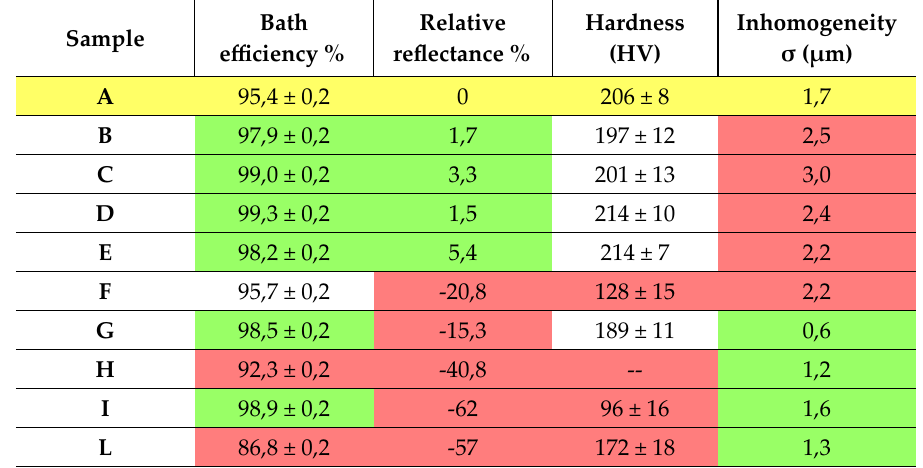
Table 3. Summary of characterisations and results obtained. In yellow the reference values obtained for the DC sample; in red the results showing a worsening compared to those obtained in DC and in green the improved